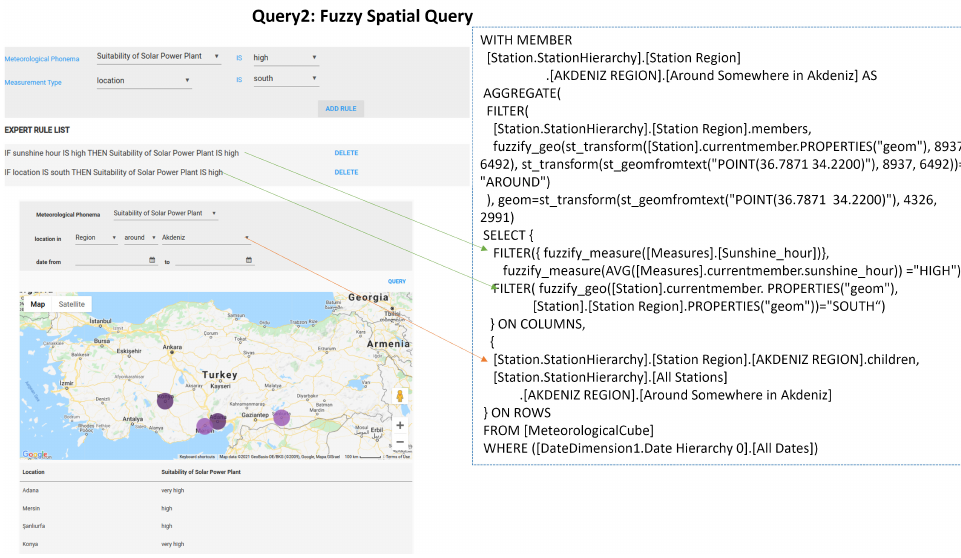
Figure 13. Fuzzy spatial